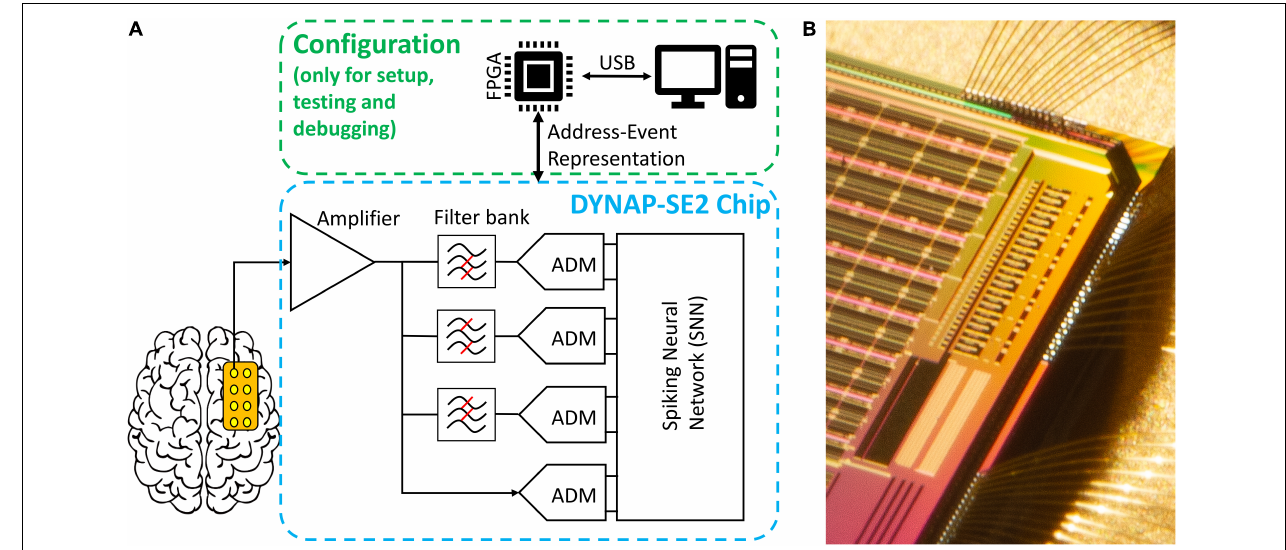
FIGURE 4 | Overview of the hardware implementation of our HFO detection system. (A) Abstract schematic of the pre-processing and configuration pipeline. Signals from the electrodes pass through amplification, filtering and analog delta modulation (ADM) delta modulation to reach the spiking neural network (SNN). The chip can be configured, send and receive data through an FPGA daughterboard and via a personal computer; note that this is not required to be online during the operation of the chip. (B) Micrograph of the eight channels of analog headstage implemented on the top-left corner of the chip (the image is rotated 90 ◦ clockwise) and they are located right next to one of the four neural